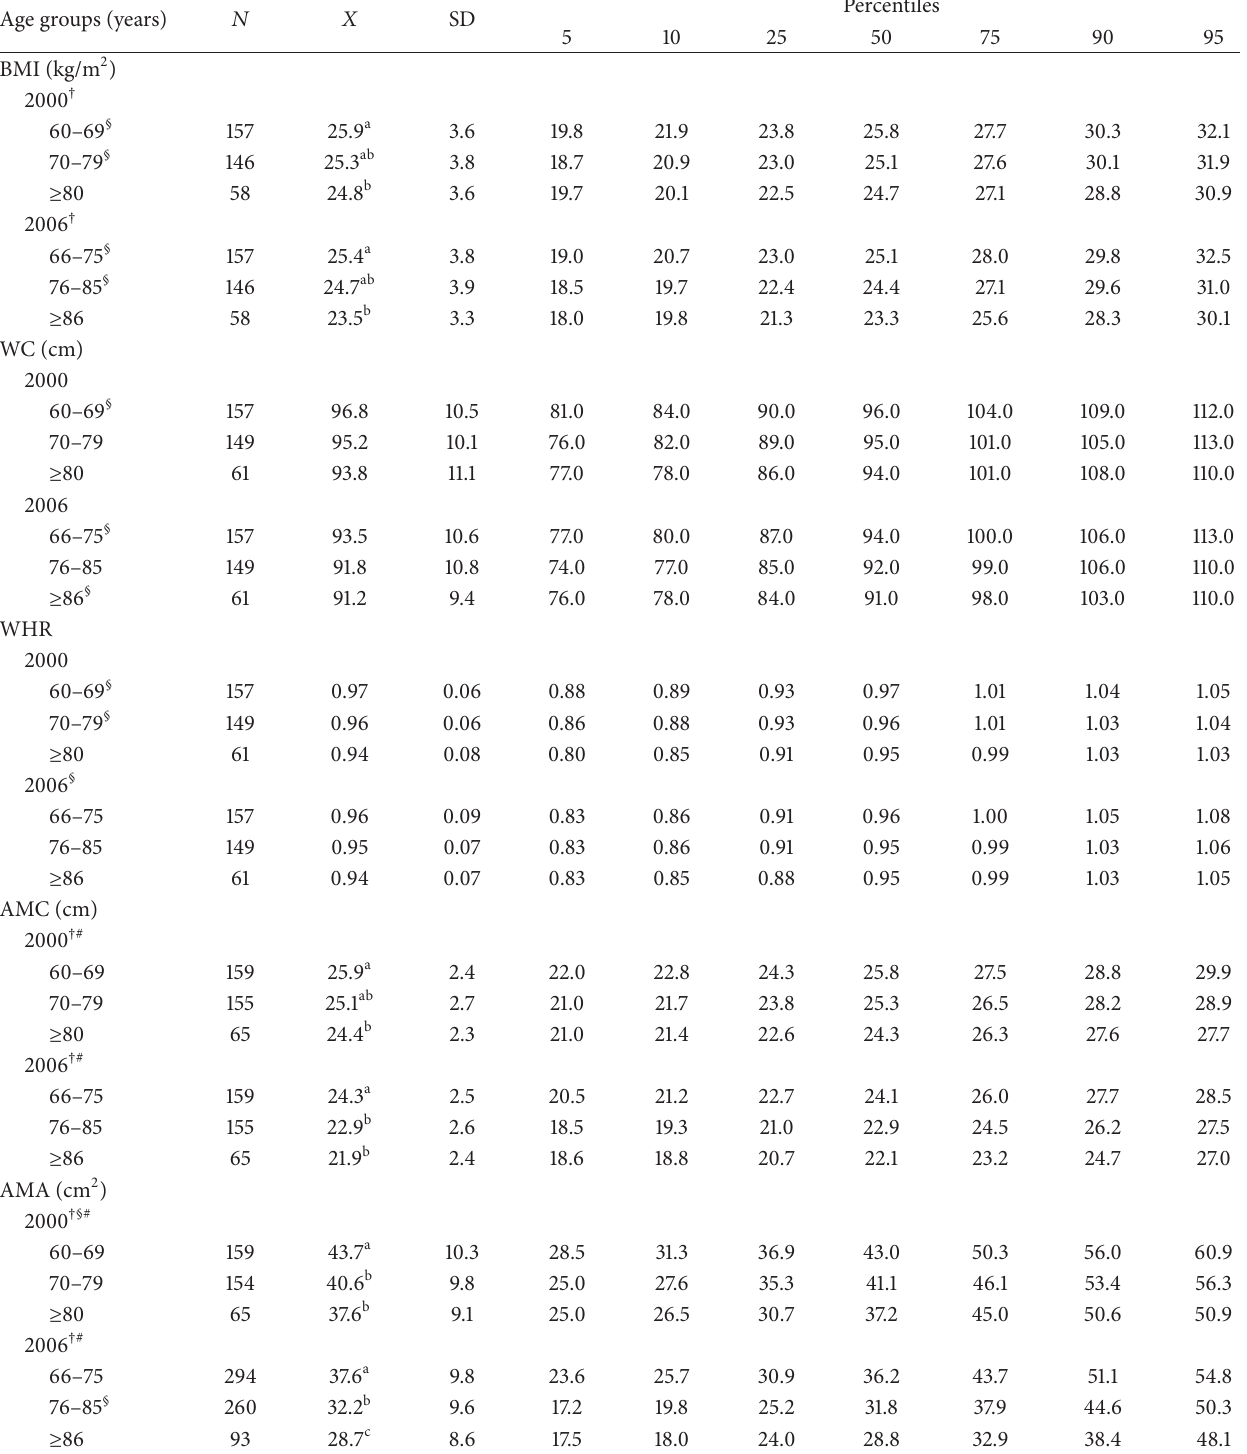
Table 4: Percentile distribution of anthropometric indicators of men by age group (SABE Survey, S˜ao Paulo, Brazil, 2000–2006). Age groups